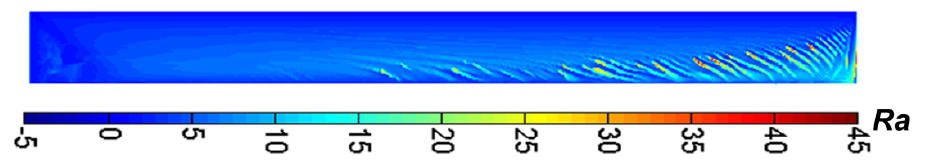
Figure 12. The Rayleigh number distribution in NbTi alloy.